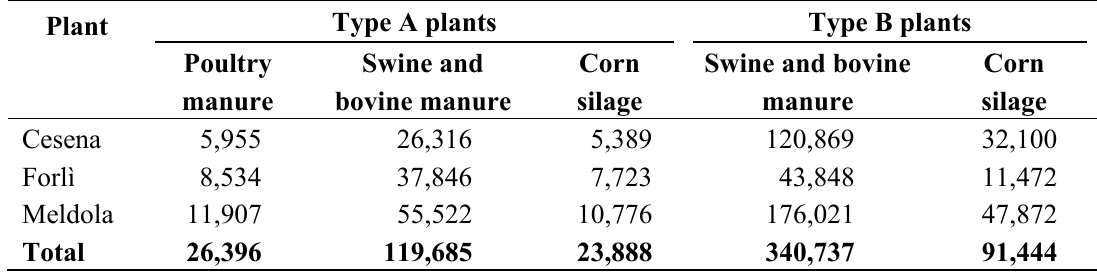
Table 8. Subdivision of available feedstock for plant types (all values in wet